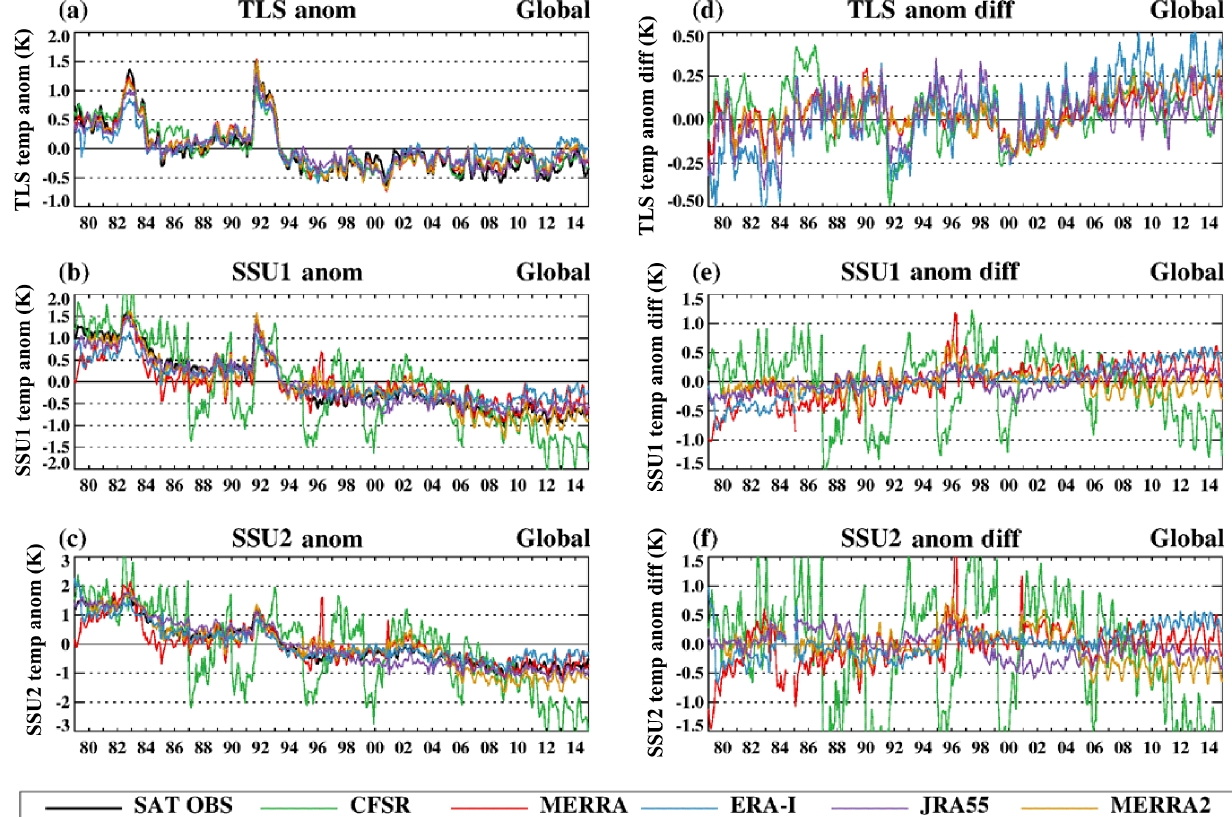
Figure 18. Time series plots of the global layer mean temperature anomalies (K) from the 1981–2010 climatology (a–c) and reanalyses anomaly differences from the NOAA STAR anomalies (d–f) for (a, d) the lower stratosphere (TLS) equivalent to the MSU 4 observations, (b, e) the middle stratosphere (SSU1) equivalent to the SSU channel 1 observations, and (c, f) the upper stratosphere (SSU2) equivalent to the SSU channel 2 observations. TLS, SSU1, and SSU2 weights are applied to the MERRA-2, MERRA, ERA-I, JRA-55, and CFSR pressure-level data to produce layer mean temperatures and anomalies. NOAA STAR TLS, SSU1, and SSU2 anomalies are plotted along with the reanalyses in the left